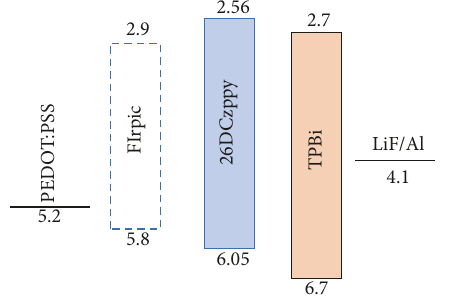
Figure 2: Energy band diagram of materials under this study.